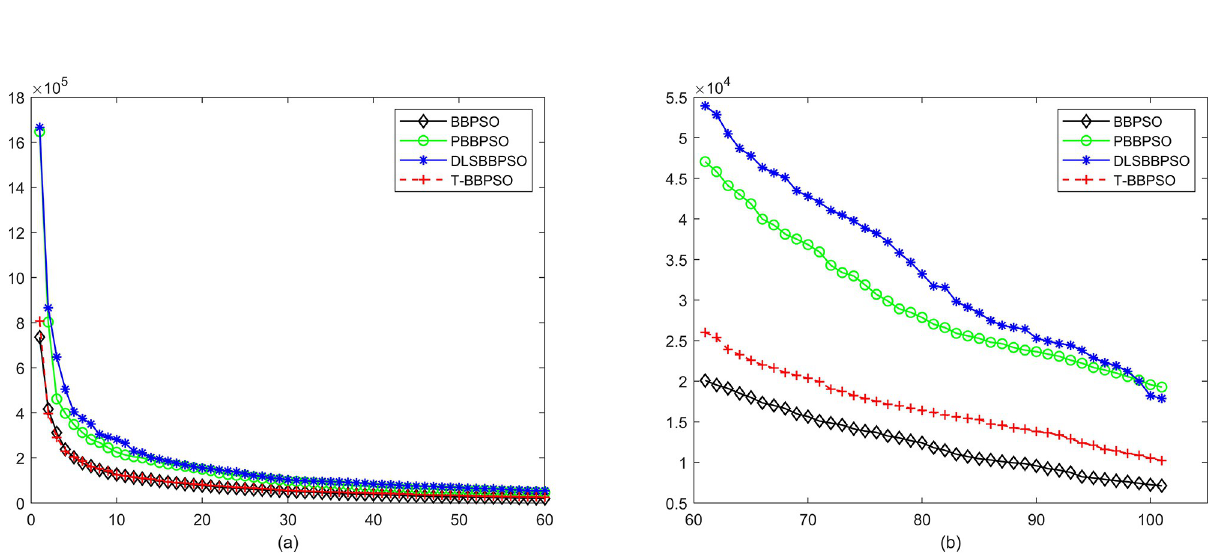
Fig 22. Comparison of convergence speed between BBPSO, PBBPSO, DLS-BBPSO and TBBPSO, f 20 , (a) iteration 0–6000, (b) iteration 6000–10000 the unit is 100 iteration.